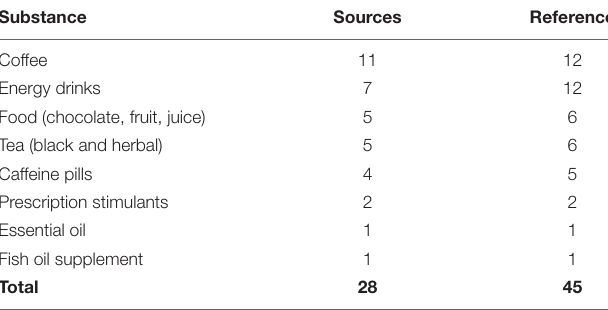
TABLE 3 | Substances currently used by university students as a problem-focused coping strategy. Substance Sources